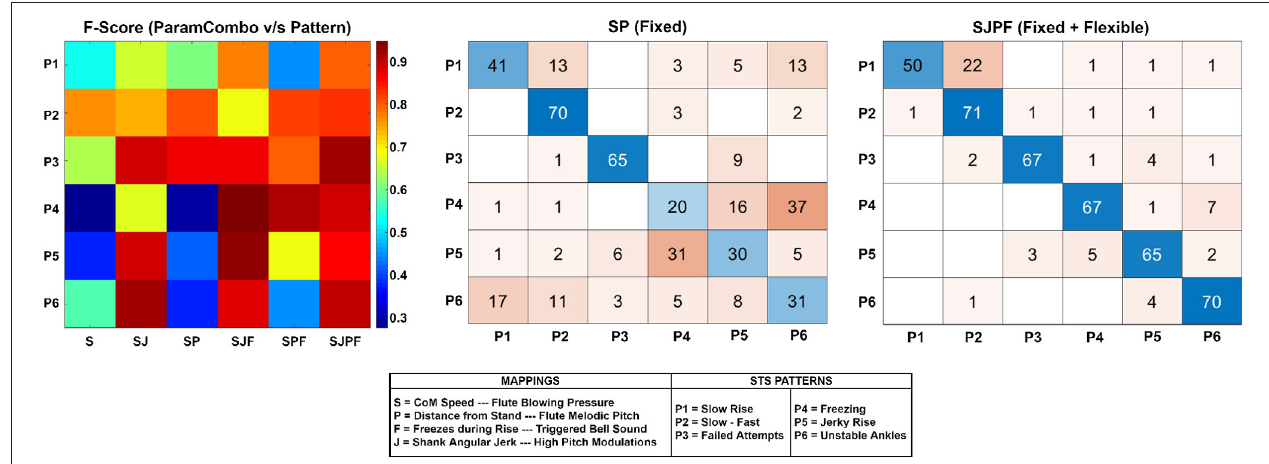
FIGURE 4 | Left: Heatmap depicting F-score distribution across patterns P1-P6 (vertical direction) and parameter combinations. Higher values indicate superior performance. Middle: The confusion matrix for the SP parameter combination (fixed component of model). Rows represent true classes, and columns represent predicted classes. Thus, the diagonal elements represent correct classifications, and the rest are incorrect. Right: Confusion matrix for the SJPF parameter combination (fixed + flexible components of